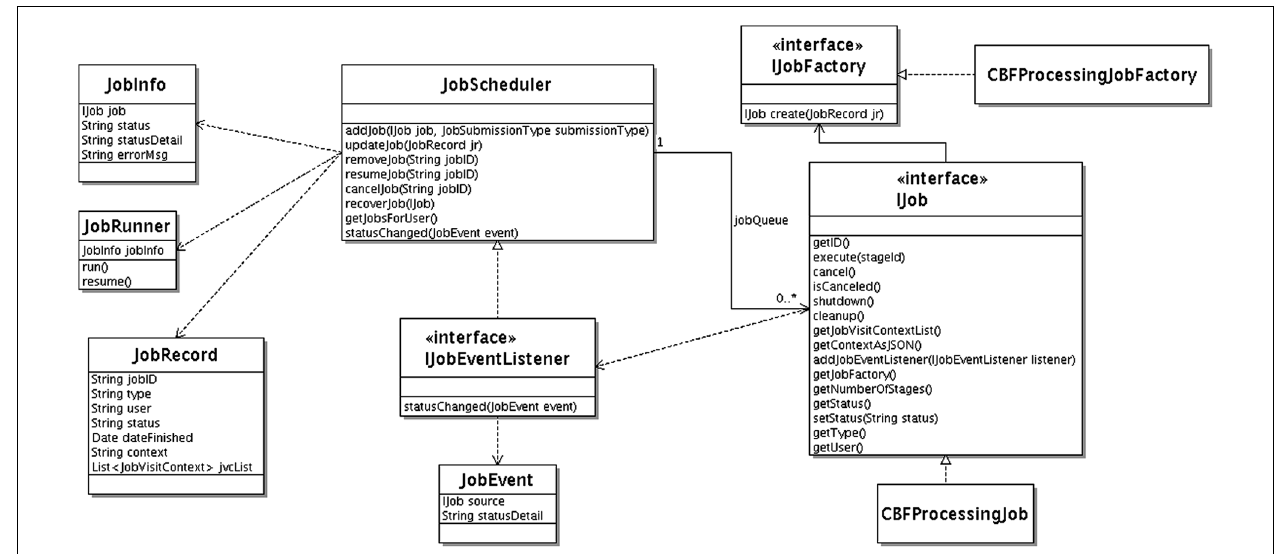
FIGURE 4 | Unified Modeling Language class diagram for CBFBIRN job